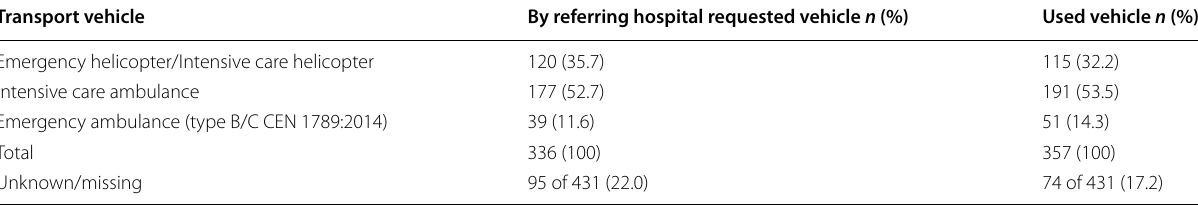
Table 4 Characteristics of rescue transport vehicle used (requested and actually